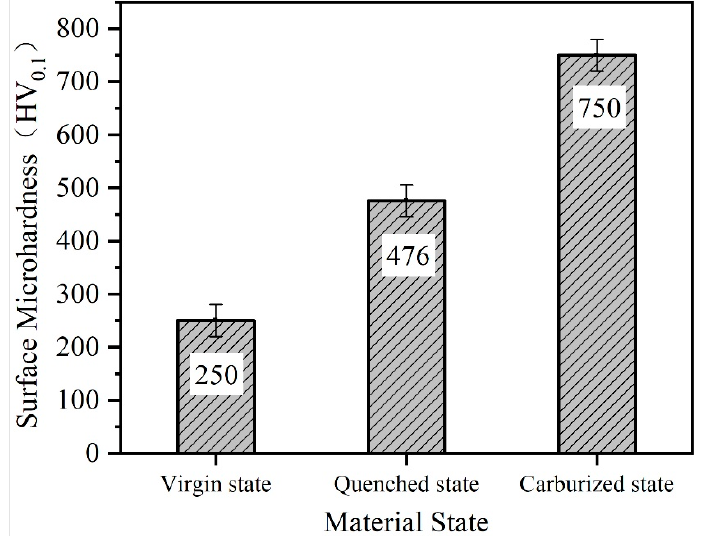
Figure 4. Surface microhardness of specimens under different material state.